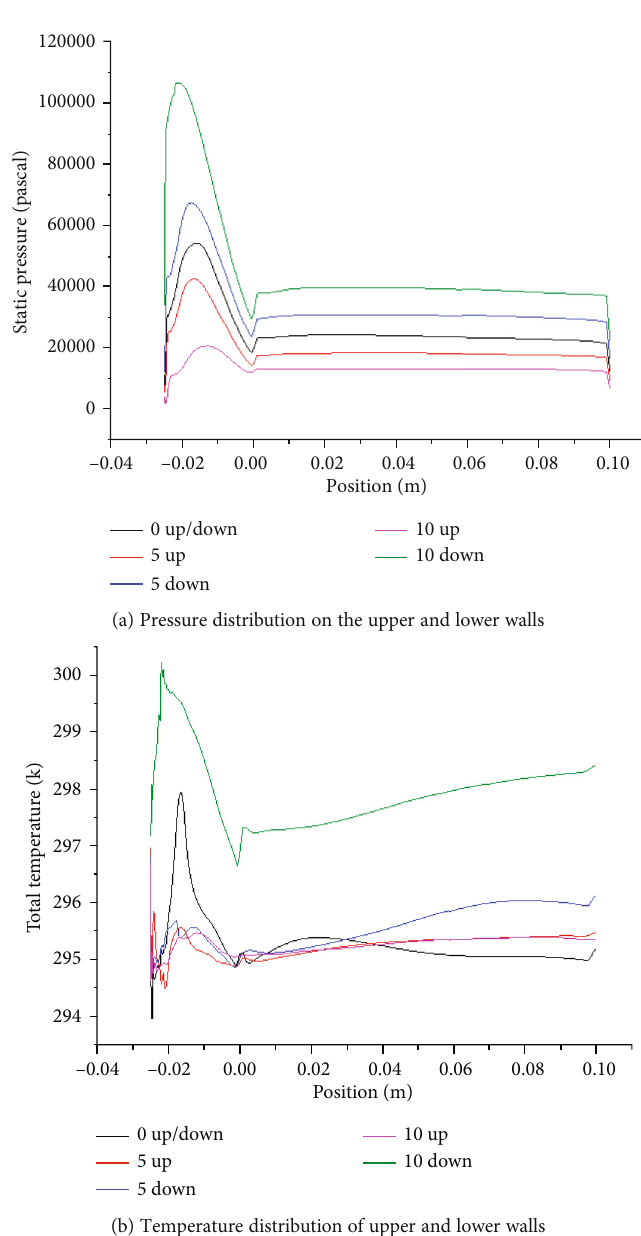
Figure 14: The pressure and temperature distribution of the upper and lower walls of Pr=0.6 at di ff erent angles of attack.